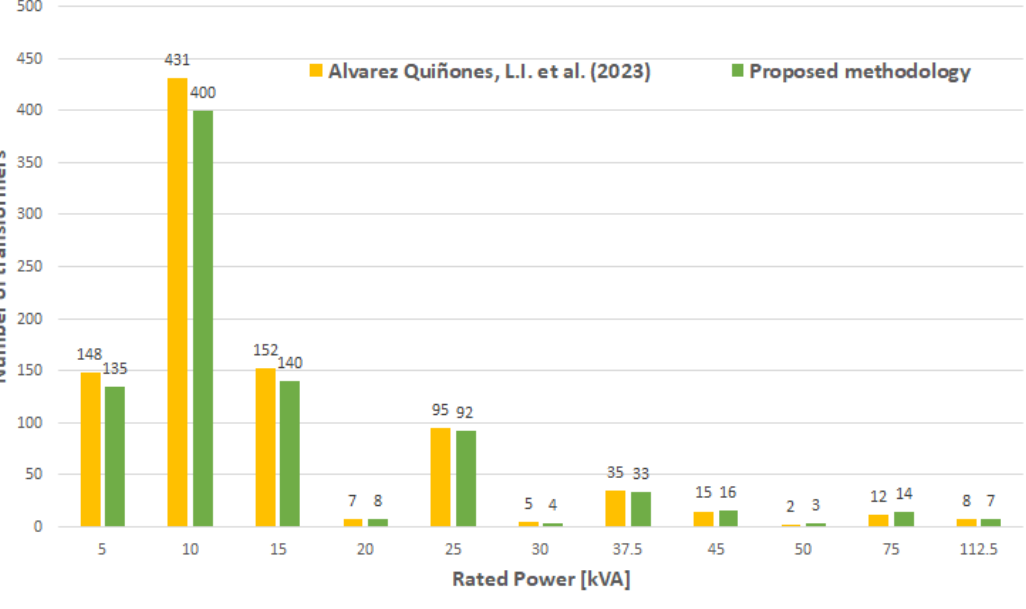
Figure 8. Predicted burned transformers during 2021 for both the methodology in [33] and the proposed methodology.